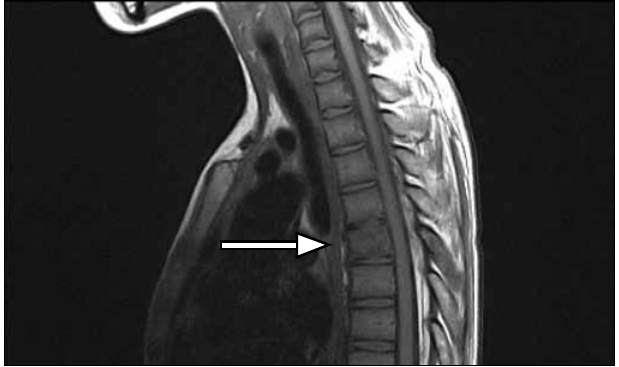
Fig.3. T1-weighted MRI shows low intensity changes of the T4 vertebra (arrow) and involvement of the inferior endplate of the vertebral body of